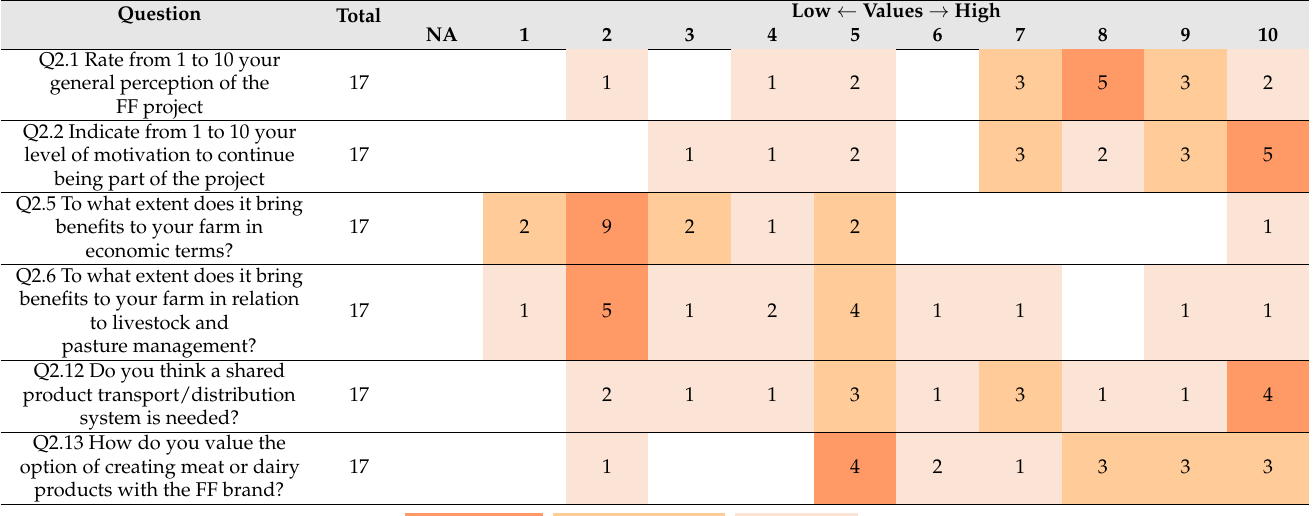
Table 3. Section 2 of the questionnaire—number of responses obtained for each value category. Values for questions on a 1–10 scale (from low to high).